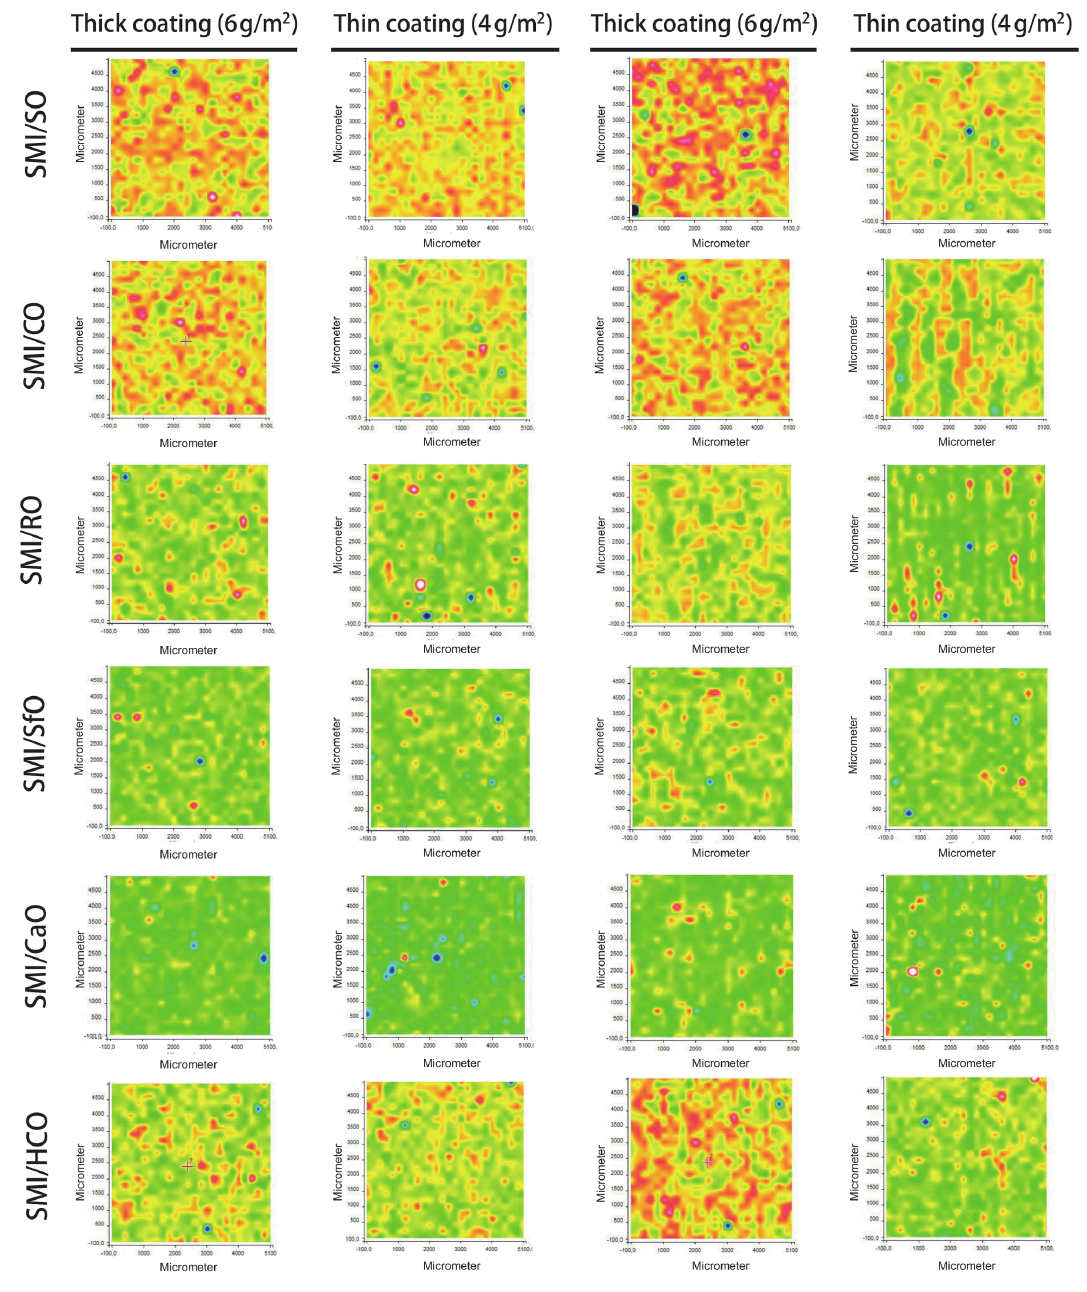
Figure 7. Raman maps (5 × 5 mm 2 ) with band intensity ratios illustrating imide moieties at the surface for SMI/oil paper coatings (left two columns: imide/styrene, right two columns: imide/cellulose). The distribution of organic coating moieties from the intensity ratios of Raman bands for styrene (1602 cm − 1 and 1000 cm − 1 ), relative to cellulose (1095 cm − 1 ), are shown in Figure 8. The maximum intensity of styrene bands is comparable for all SMI/oil coating types and does not strongly differ with the oil type, because all copolymers contain a fixed amount of 74 mol % styrene that remains inert during the synthesis of the SMI/oil nanoparticles. The differences in intensities of styrene therefore mainly correspond to variations in coating coverage. In particular, the effects of thin and thick coatings are visualized. The locations for coverage of styrene components represented by Raman bands at 1602 cm − 1 and 1000 cm − 1 are in agreement, but slight differences in intensity may be attributed to the specific orientation of the styrene parts. The styrene-related absorption bands are characteristic